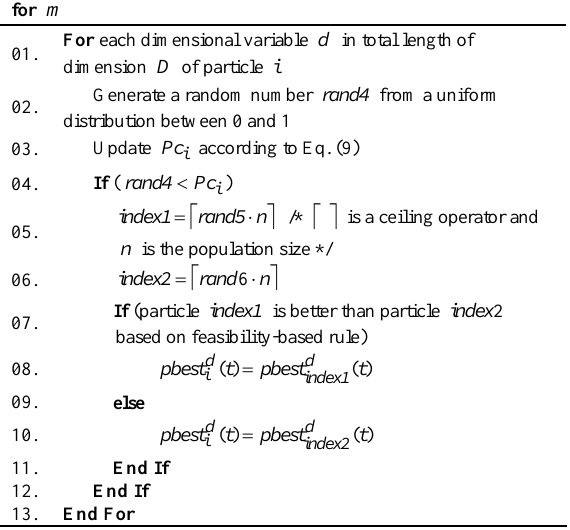
Table 2. Pseudo-code for updating pbest after a particle ceases improving for the refreshing gap m